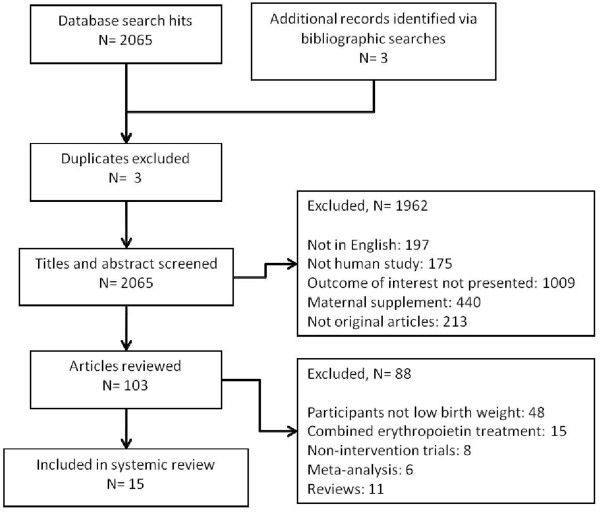
Study flow diagram.